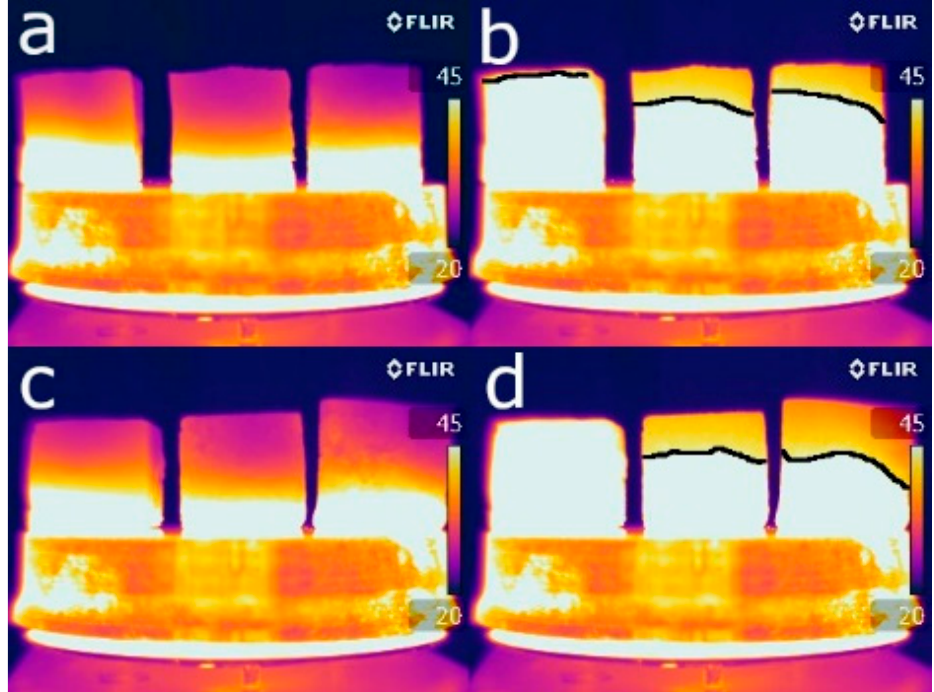
Figure 10. Thermographic images of the control samples (on the left in each image), the samples with EPS (centre) and the samples with olive stones (right), using 20% volume of additive ( a , b ) and 60% ( c , d ). Images were taken after 5 min ( a , c ) and 30 min ( b , d ) of heating.